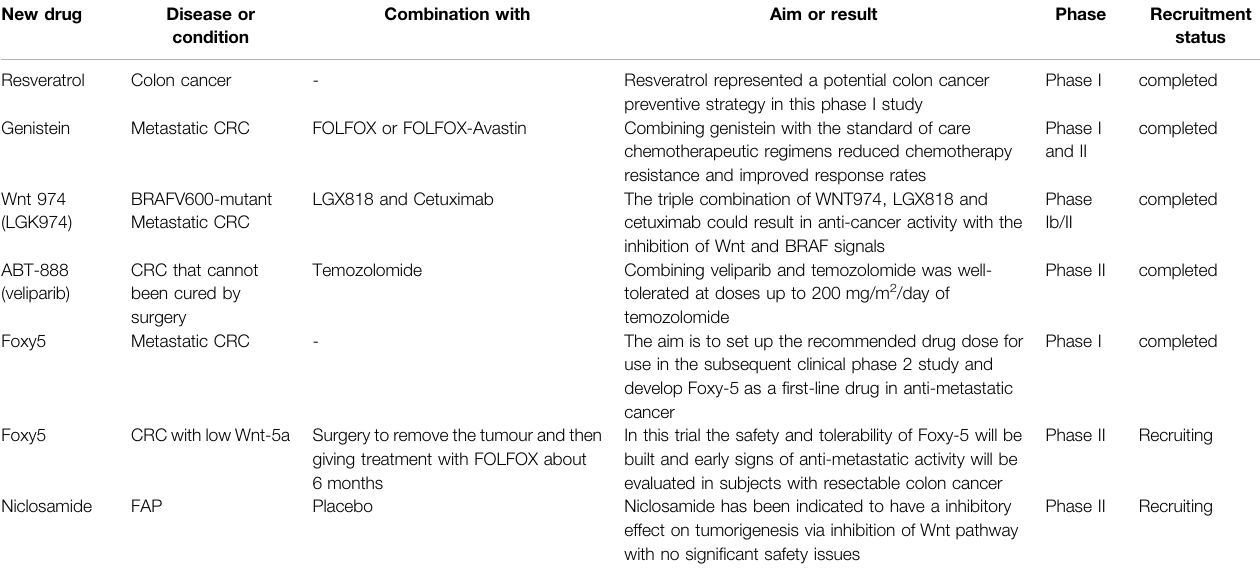
TABLE 3 | New drugs inhibiting Wnt/ β -catenin pathway for treatment CRC in clinic. New drug Disease or